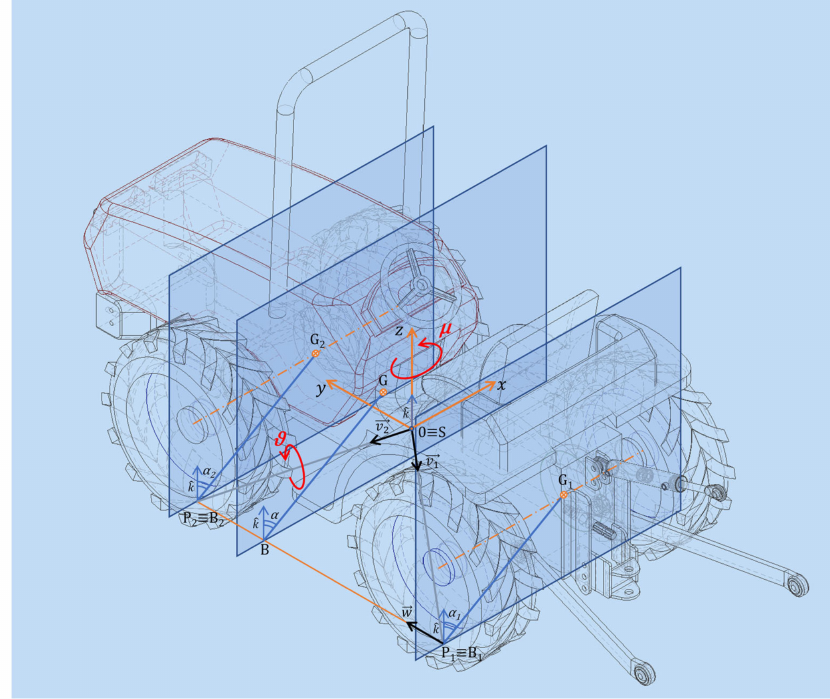
Figure 5. Graphical representation of the input tractor parameters considered in the simulation.